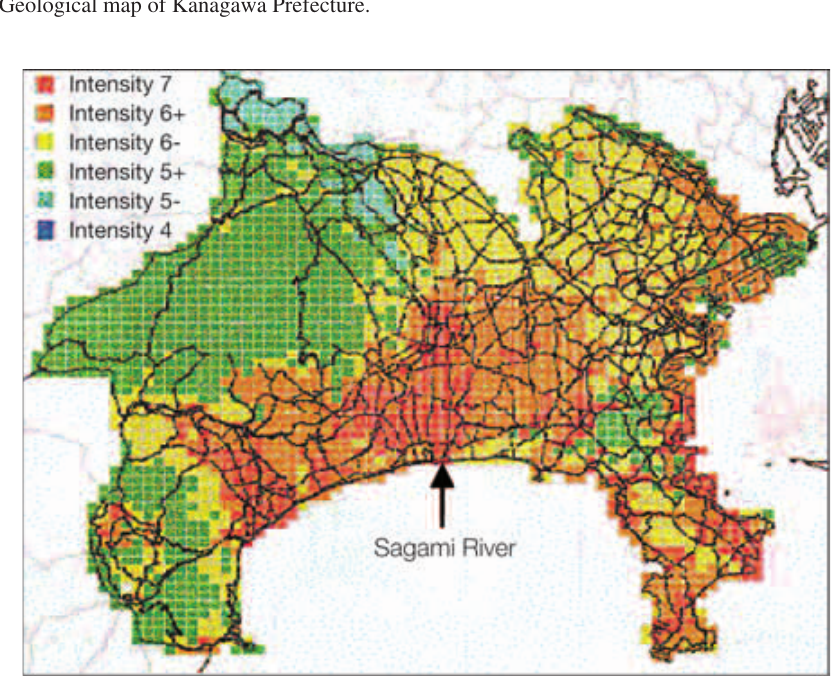
Fig. 7. Calculated seismic intensity map for the Kanto earthquake (Kanagawa Prefecture,